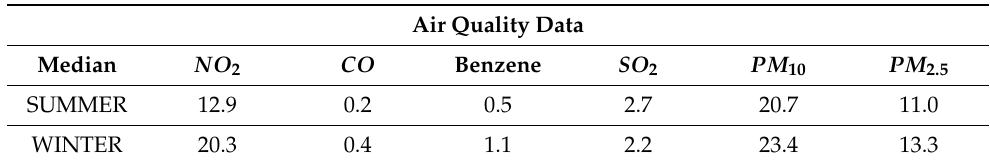
Table 2. Median of the air quality variables measured across the entire analysis period calculated separately for the summer and winter seasons.